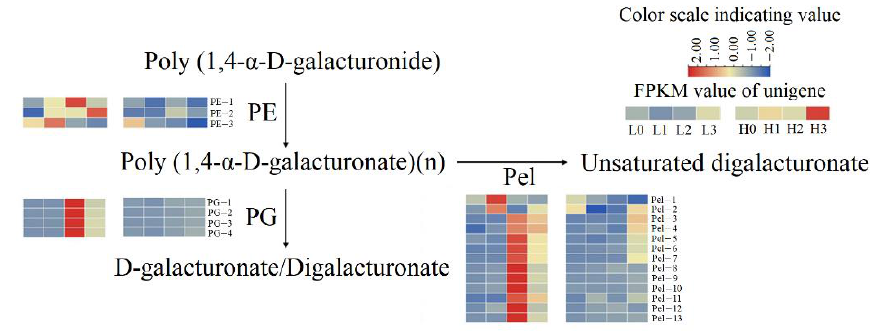
Figure 6. Pectin cleavage pathway. FPKM values of unigenes of the enzymes are indicated from blue to red (low to high) across the stage 0, stage 1, stage 2, and stage 3 under low R/FR ratio (L0, L1, L2, and L3) and high R/FR ratio (H0, H1, H2 and H3). PE: pectinesterase; PG: polygalacturonase; Pel: pectate lyase.